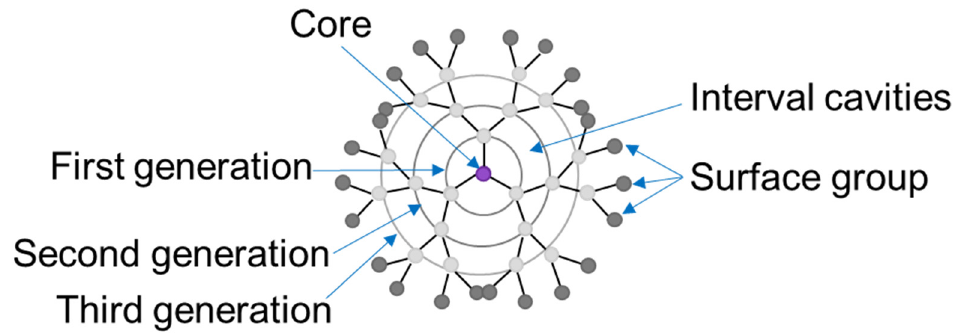
Figure 2. Diagram of a dendrimer structure.